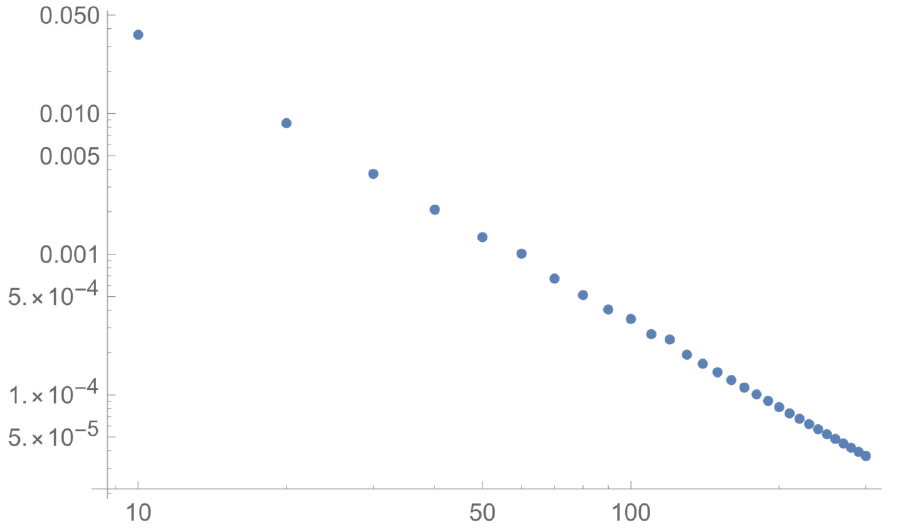
Figure 5. IPOPT performance on tightened LSP model-instances up to n = 300. Difference between the area A ( n ) of the optimized polygon and π /4.